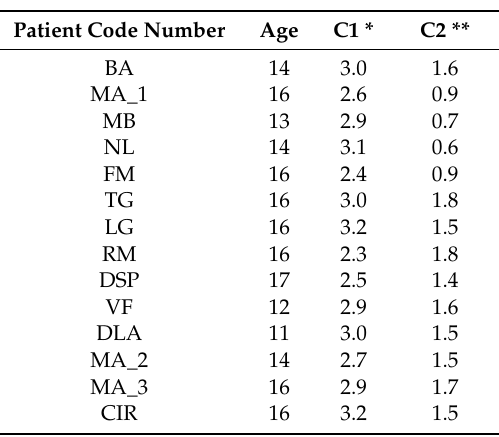
Table 1. Patient Control